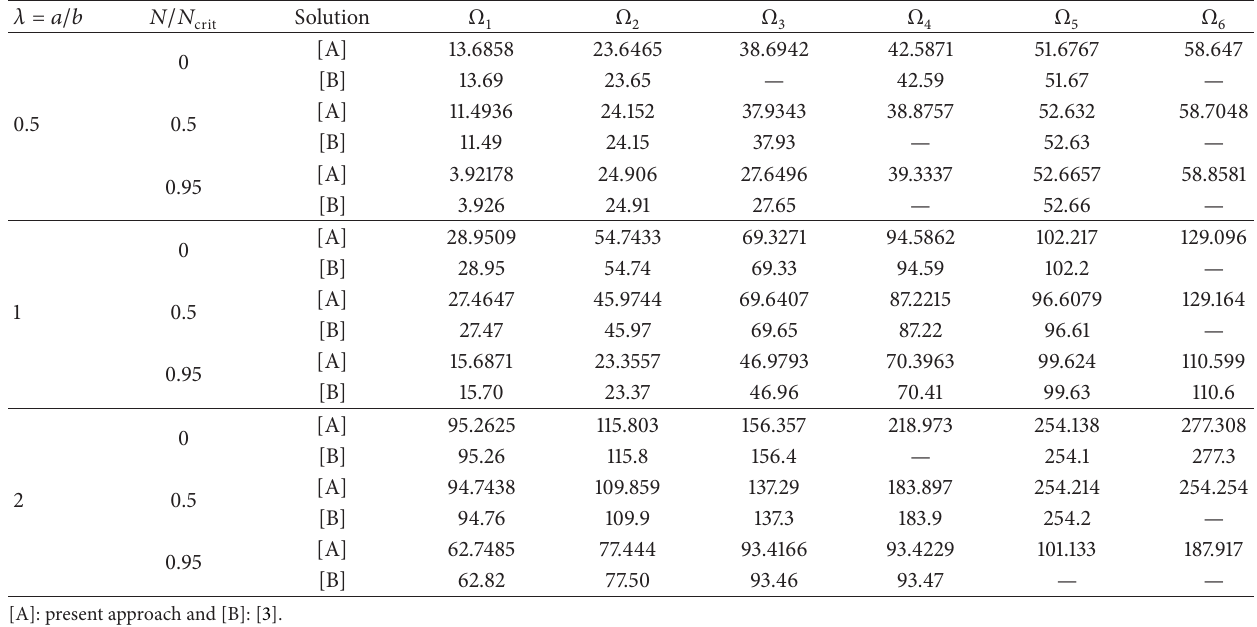
Table 5: Comparison of the first six natural frequency coefficients for a SS-C-SS-C plate under bending moment in 𝑥 -direction ( 𝛼 = 2 ).